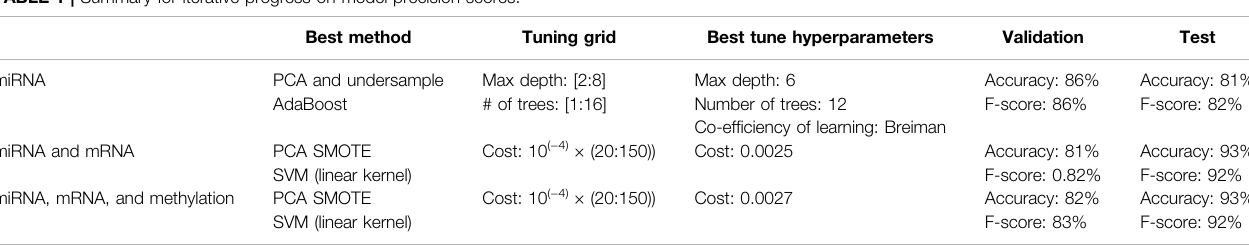
TABLE 1 | Summary for iterative progress on model precision scores.